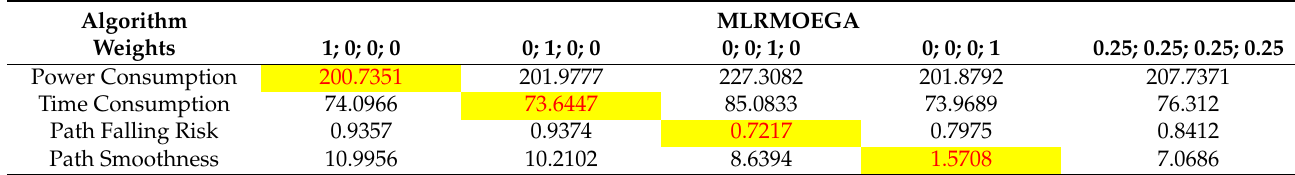
Table 14. Results of Multi-Objective Optimization Performance